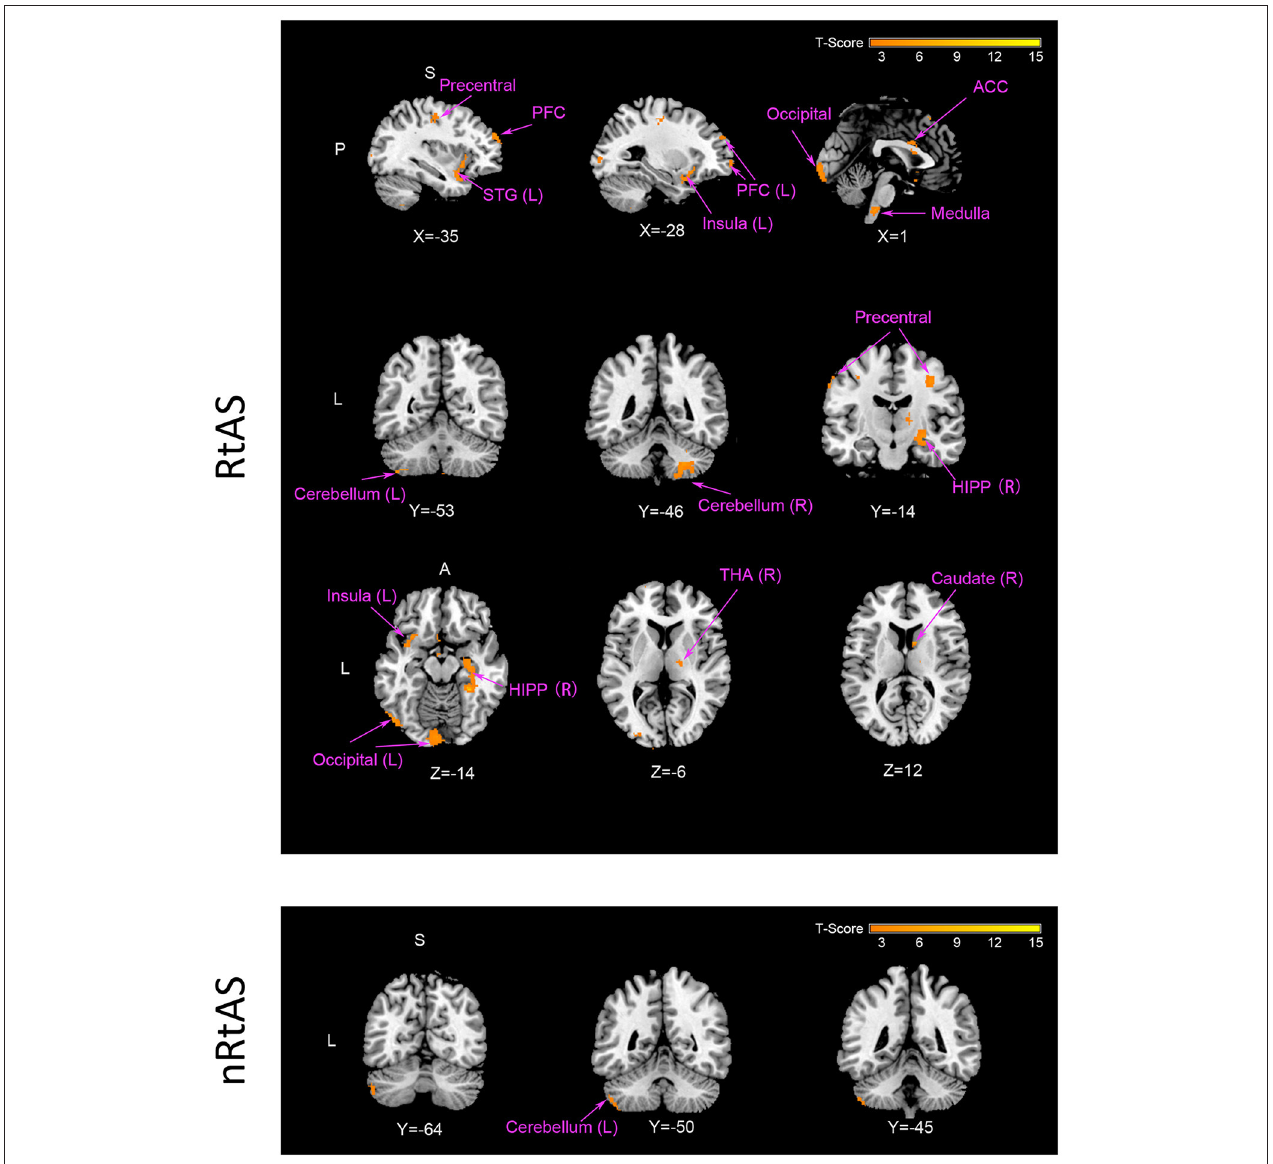
FIGURE 2 | CBF increment by taVNS. The RtAS group: taVNS increased the RtAS DOC patients’ CBF in this study in many brain regions presented in this figure: STG (L) of temporal lobe; PFC (L) including SFG (L), MFG (L), and IFG (L); medulla; cerebellum (L) and cerebellum (R); precentral; caudate (R); HIPP (R); insula (L); occipital (L); THA (R). Images displayed in Montreal Neurological Institute standard stereotaxic space, and coordinates are provided for each slice. STG (L), left superior temporal gyrus; PFC (L), left prefrontal cortex including left superior frontal gyrus [SFG (L)], left middle frontal gyrus [MFG (L)], and left inferior frontal gyrus [IFG (R)]; cerebellum (L), left cerebellum; cerebellum (R), right cerebellum; precentral, precentral gyrus; caudate (R), right caudate; HIPP (R), right hippocampus; insula (L), left insula; occipital (L), left occipital lobe; THA (R), right thalamus. The nRtAS group: taVNS increased the nRtAS DOC patients’ CBF only in the left cerebellum. Images displayed in Montreal Neurological Institute standard stereotaxic space and coordinates are provided for each slice. Cerebellum (L), left cerebellum. Uncorrected P < 0.05, T >